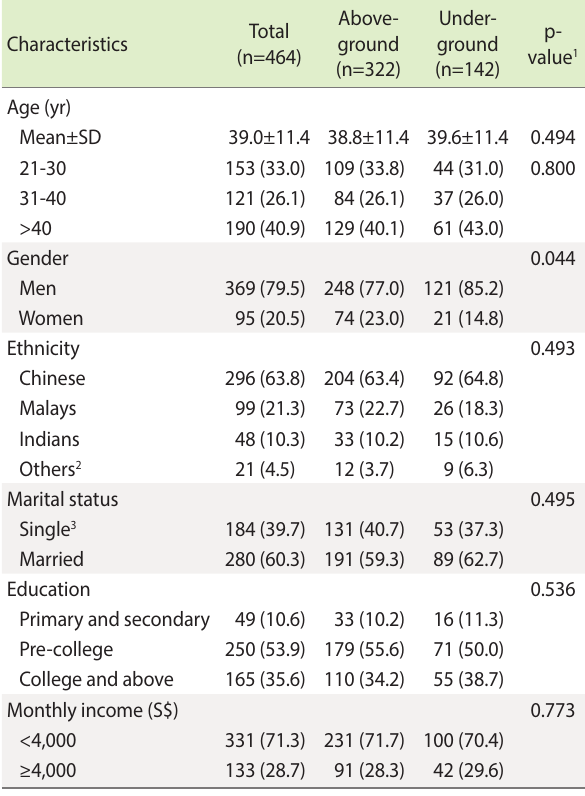
Table 2. Socio-demographic characteristics of the study cohort at baseline